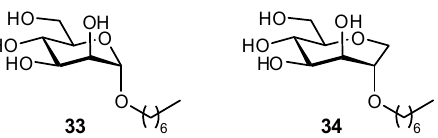
Figure 11. n -Heptyl pyranose and septanose FimH ligands have been used to study the effects of pre-organization on binding thermodynamics [86] .